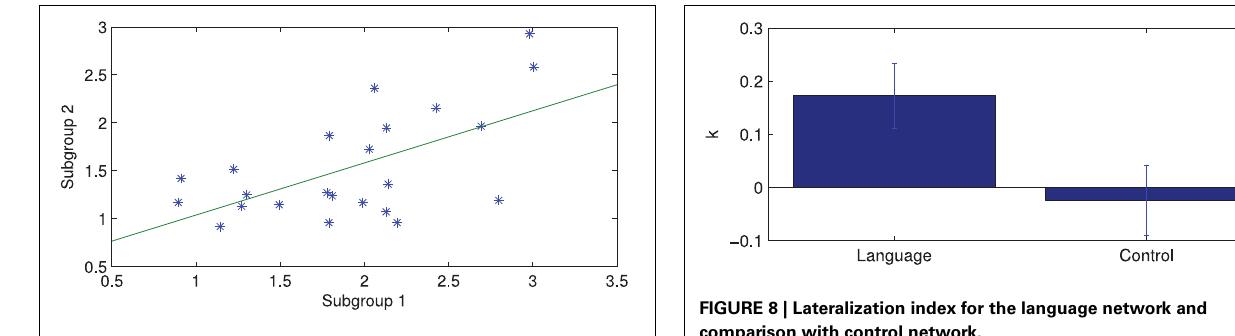
FIGURE 6 | Correlation between connection strengths in the two subgroups.